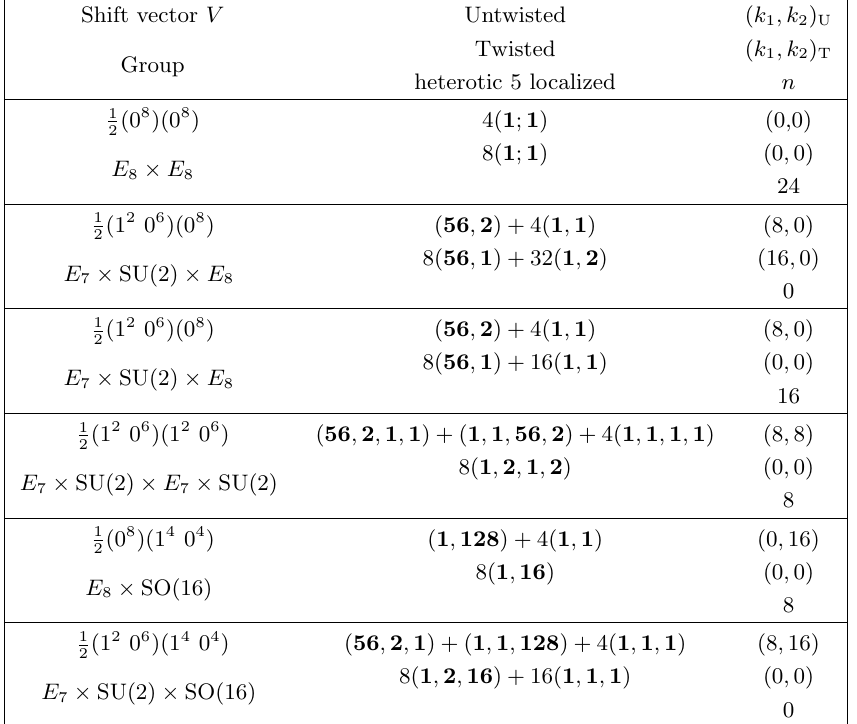
Table 4 . Perturbative ( n = 0) and non-perturbative vacua of E 8 (cid:2) E 8 heterotic string on T 4 = Z 2